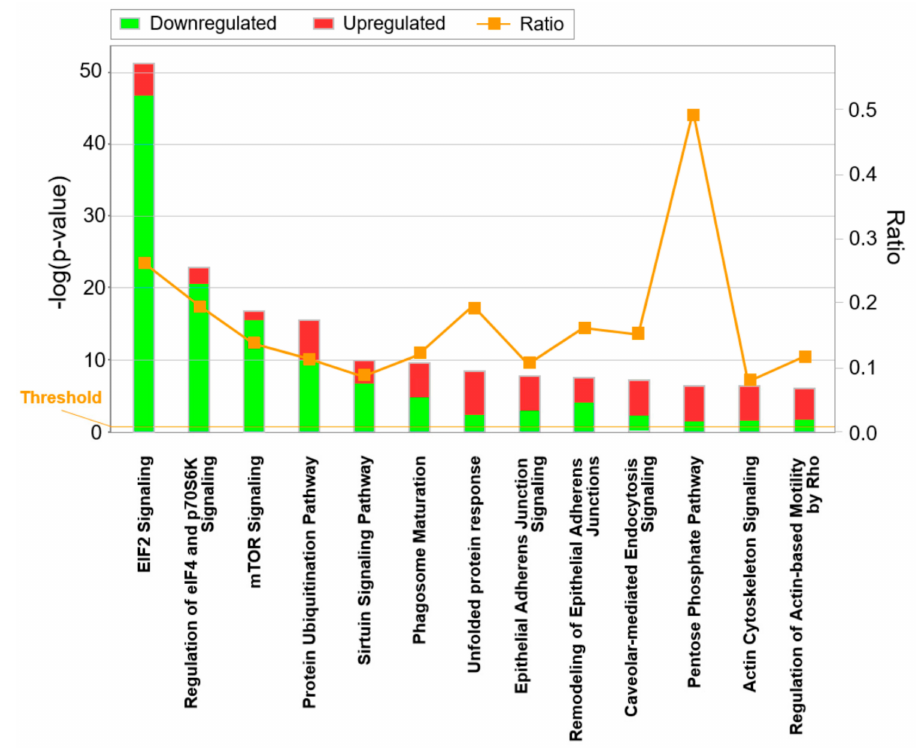
Figure 3. Canonical Ingenuity Pathway Analysis (IPA) pathways altered in pancreatic TICs ranked by significance: For each pathway (x-axis), ratios of significantly up- or downregulated proteins are represented in red and green, respectively. − log( p -value) is the negative decadic logarithm of the probability that the observed association between a specific pathway, and the dataset is only due to random chance according to Fisher’s exact test; the ratio is the quotient between the number of genes detected in our particular analysis (identified via the corresponding proteins) and the number of genes contained in the Ingenuity database for the specific canonical